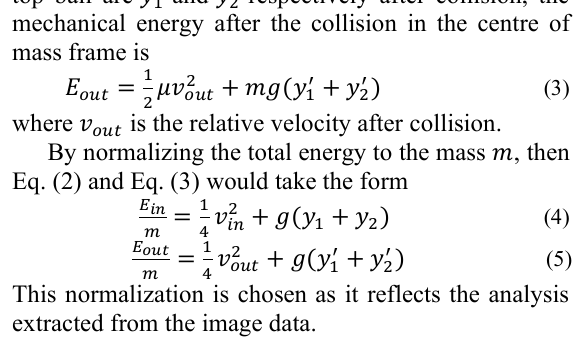
Fig. 4. Plot of relative velocity after collision 𝑣 𝑜𝑢𝑡 against the relative velocity before collision 𝑣 𝑖𝑛 in the lab frame for the data with coefficient of restitution less than or equal to 1. Parameters are as follows ： (a) 𝑓 1 = 29.52 𝐻𝑧 , Γ 1 = 2.42 𝑔